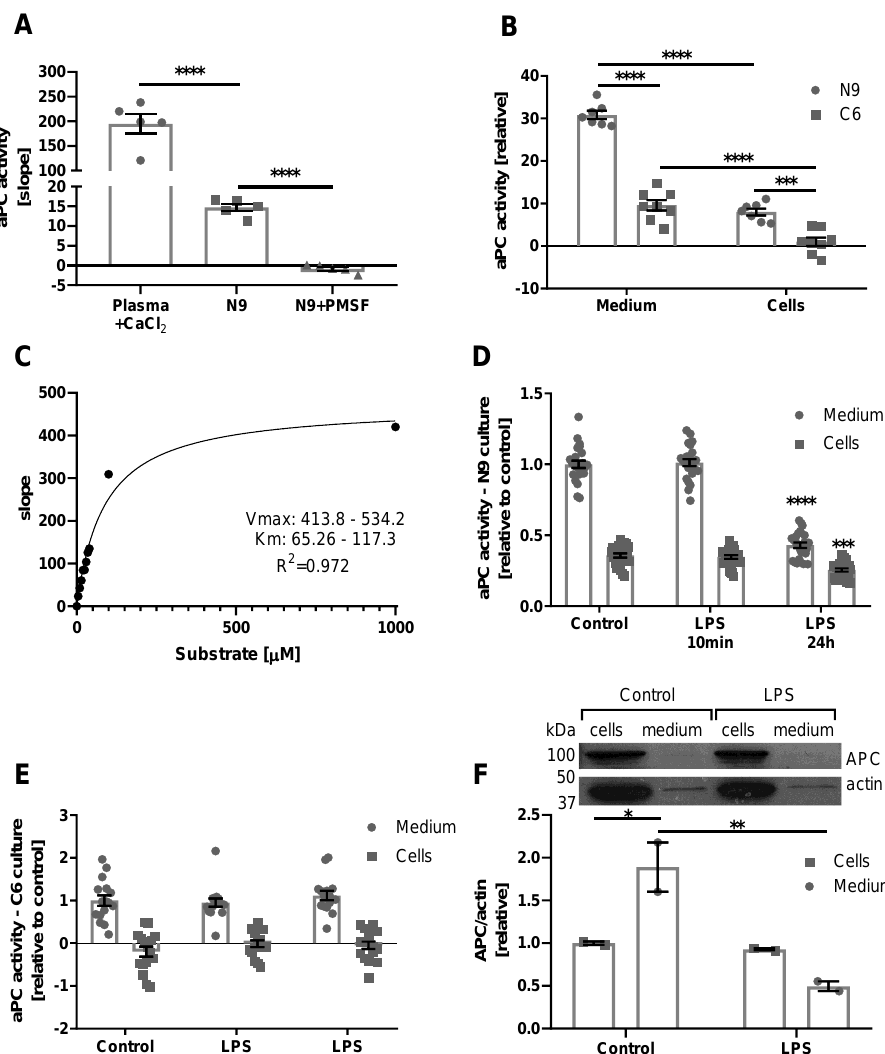
Figure 2. APC activity in N9 and C6 cells in normal conditions and lipopolysaccharide (LPS) model. ( A ) APC activity in activated plasma compared to N9 cells: APC activity in activated plasma ( n = 5) is significantly higher compared to APC activity in N9 cell culture ( n = 5, p < 0.0001). APC activity in N9 culture is completely inhibited following phenylmethylsulfonyl fluoride (PMSF) treatment ( n = 5, p < 0.0001). ( B ) APC activity in the medium and on the cells of N9 and C6 cells: APC activity is significantly higher in the medium compared to APC activity on the cells of N9 and C6 cells ( n = 8, p < 0.0001). APC activity in the medium of N9 cells is significantly higher compared to APC activity in the medium of C6 cells ( n = 8, p < 0.0001). APC activity on the cells of N9 cells is significantly higher compared to APC activity on the cells of C6 cells ( n = 8, p = 0.0003). ( C ) Michaelis-Menten saturation curve of the substrate: The measured activity showed a good fit to Michaelis–Menten saturation curve with K m = 65.26 – 117.3 and V max =413.8 – 534.2 ( R 2 = 0.972). ( D ) APC activity in N9 cells in LPS model: APC activity in the medium and on the cells of N9 did not changed significantly after 10 min treatment of LPS (0.1 µg/mL). Twenty-four-hour treatment of LPS significantly decreased APC activity in the medium and on the cells of N9 ( n = 24, p < 0.0001 and p = 0.0006 respectively). ( E ) APC activity in C6 cells in LPS model: APC activity did not change significantly after short or long LPS treatment in the medium and on the cells of C6 ( n = 16). ( F ) APC protein levels in N9 cells in LPS model: APC/actin levels are significantly higher in the medium compared to cells ( n = 2, p = 0.0259) and significantly decrease in the medium following LPS treatment ( n = 2, p = 0.0052).